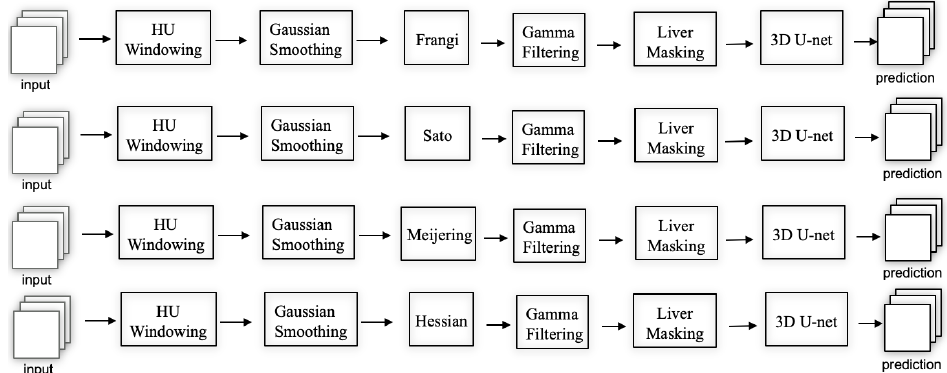
Figure 4. Workflow of different vesselness enhancement approaches with gamma